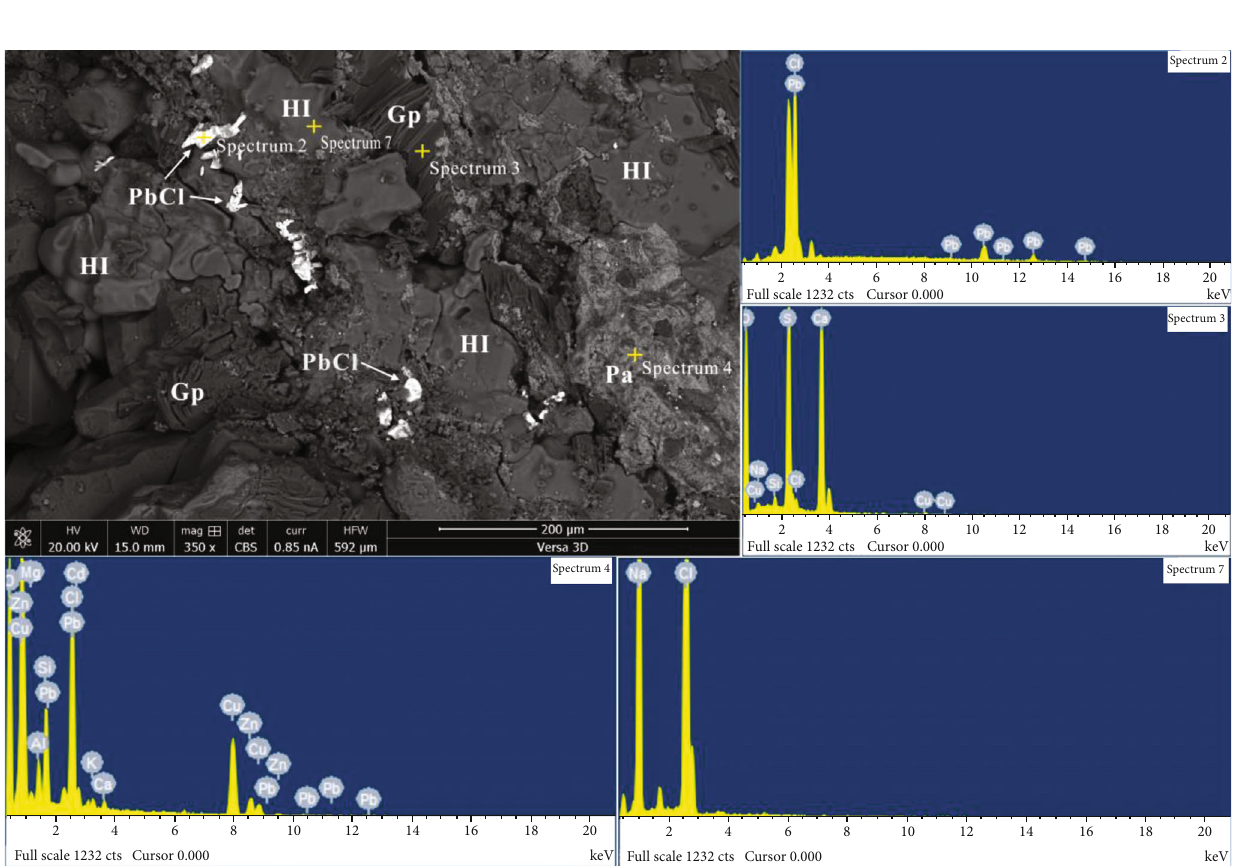
Figure 5: SEM and EDS analysis of sample KC-G gypsum; Pa: paratacamite; HI: halite. The bright white mineral containing Pb and Cl might be PbCl Cl, O, and a few Si, Al, Ca, K, Pb, and Zn, is paratacamite (Cu containing Na and Cl is halite (NaCl). The ash black mineral containing Ca, S, and O is gypsum (CaSO